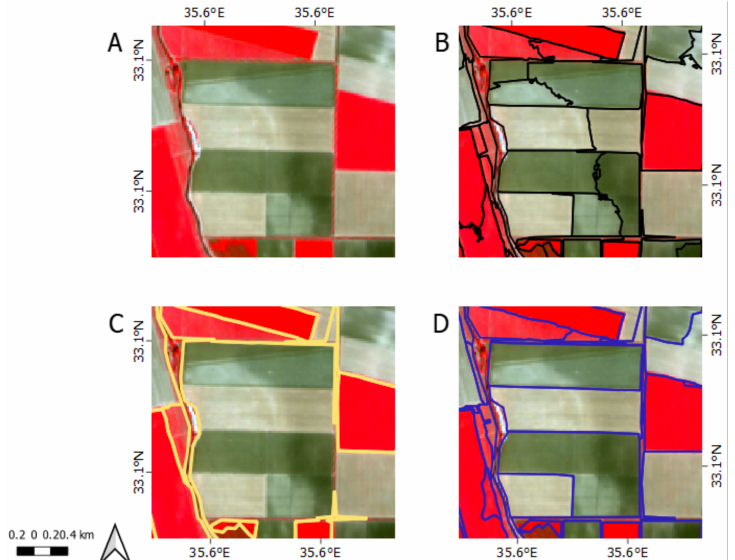
Figure 8. An example of mean shift segmentation output using the blue, red, and NIR bands as input and high/low spectral and spatial parameters. ( A ) Input image (the green, red, and NIR bands). ( B ) Segmentation output using high emphasis on the spectral characteristic and low emphasis on the spatial characteristic (Combination 2). ( C ) Segmentation output using low emphasis on the spectral characteristic and high emphasis on the spatial characteristic (Combination 3). ( D ) Segmentation output using high emphasis on the spectral and spatial characteristics (Combination